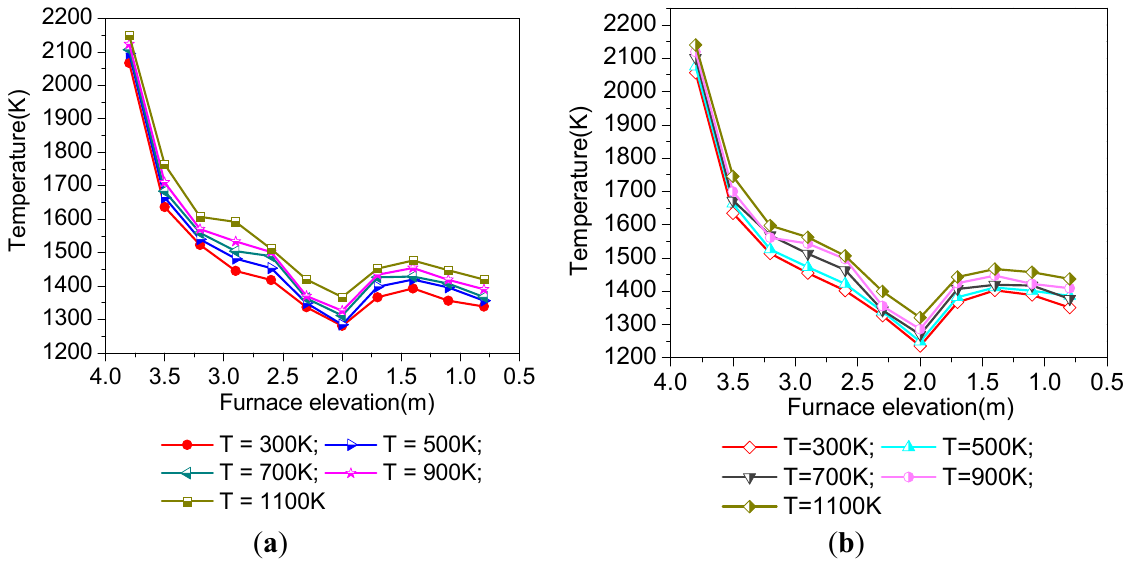
Figure 10. Temperature distributions along with the height of the furnace under different temperatures of the secondary air: ( a ) SAm reburning; and ( b ) cornstalk